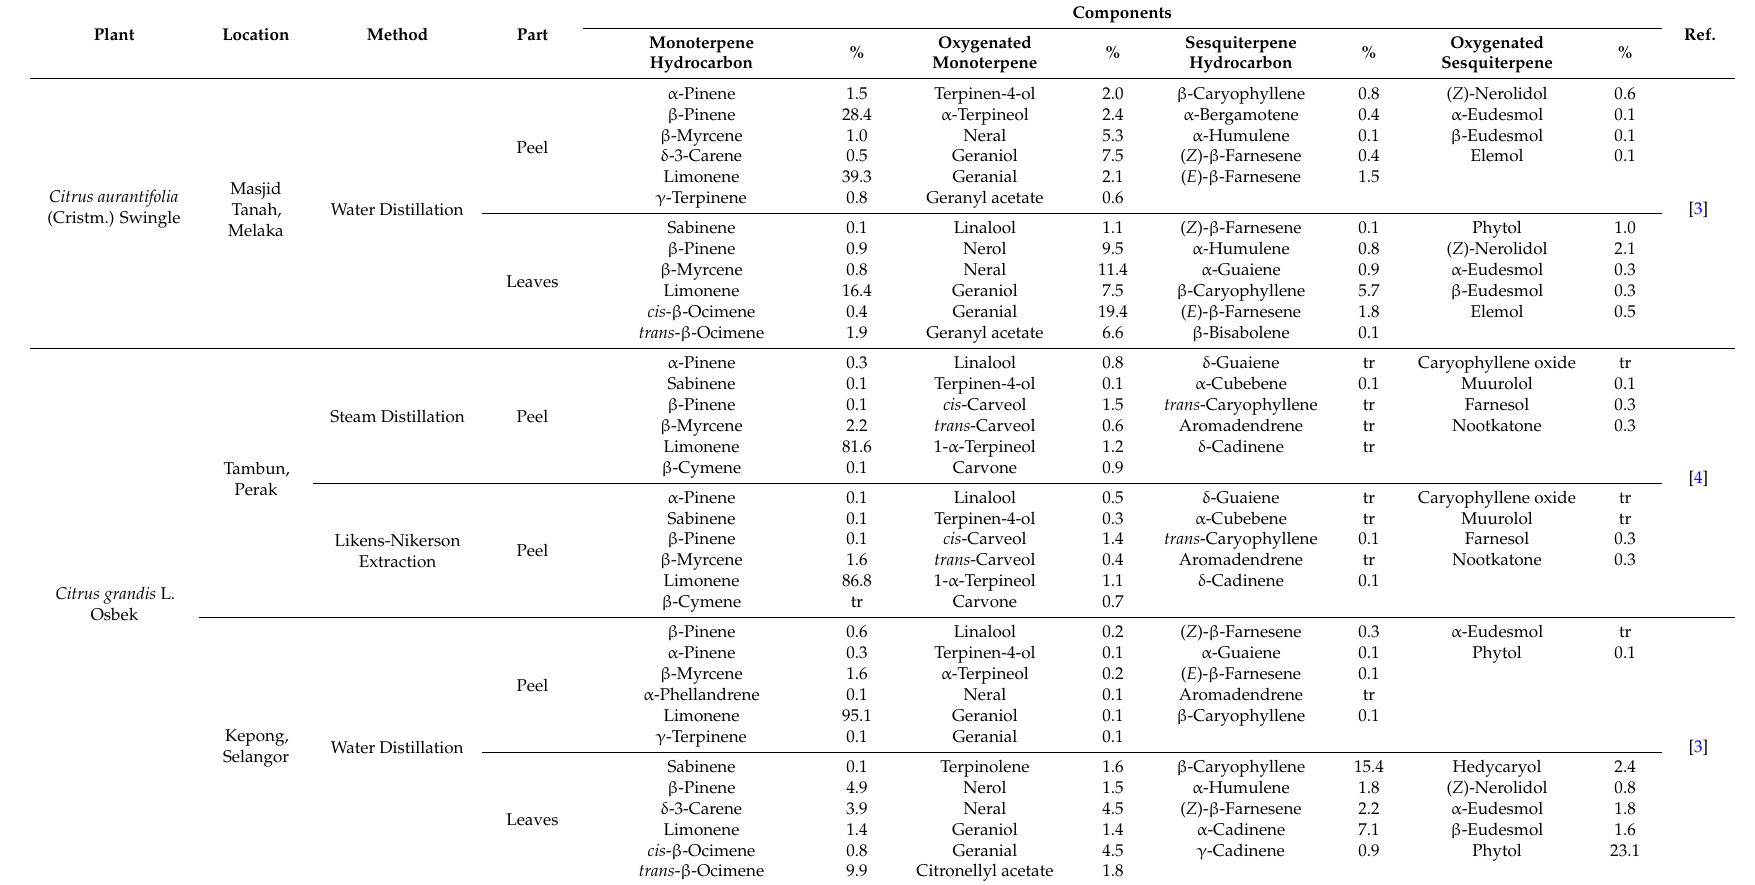
Table 1. Composition of Essential Oil of Citrus Species in